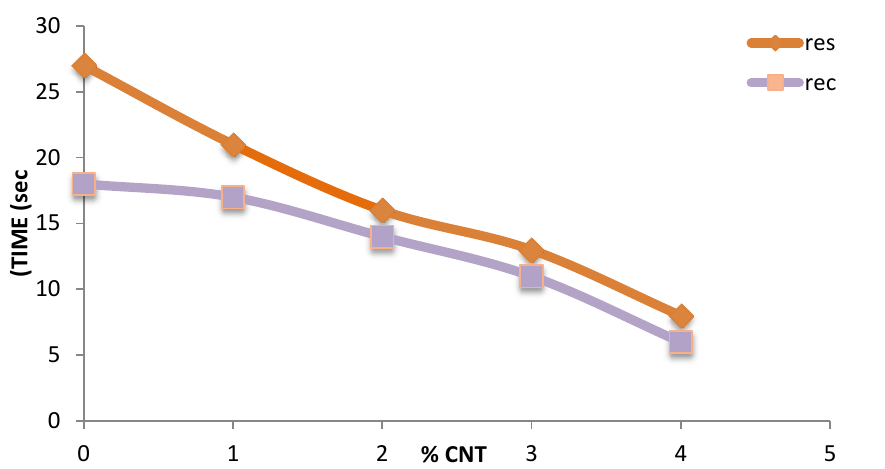
Fig. 14: Comparisons between response time and recovery time for humidity sensors as a function of MWCNT